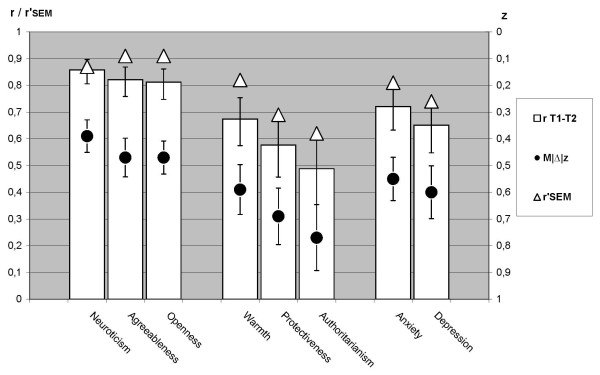
Observed and true stability. Observed stability correlations r (bars, with scale on the left) and mean absolute standardized change M|Δ|z (black filled circles, with scale on the right) for each scale, with 95 percentile confidence intervals indicated for both. True stability estimates from SEM analyses are indicated with triangles. Both vertical scales are arranged with maximum stability at upper end.